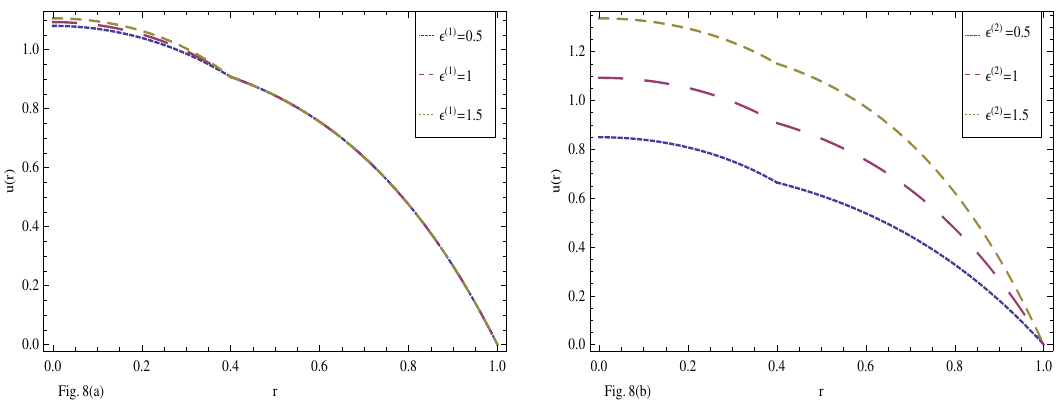
Figure 8. Effect of ( a ) (cid:101) ( 1 ) and ( b ) (cid:101) ( 2 ) on the velocities of the two fluids.